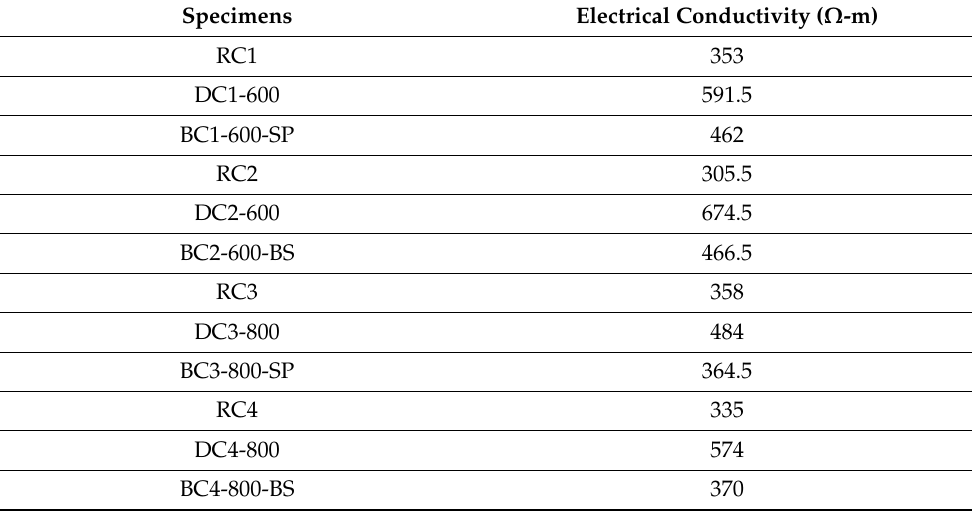
Table 5. Electrical conductivity